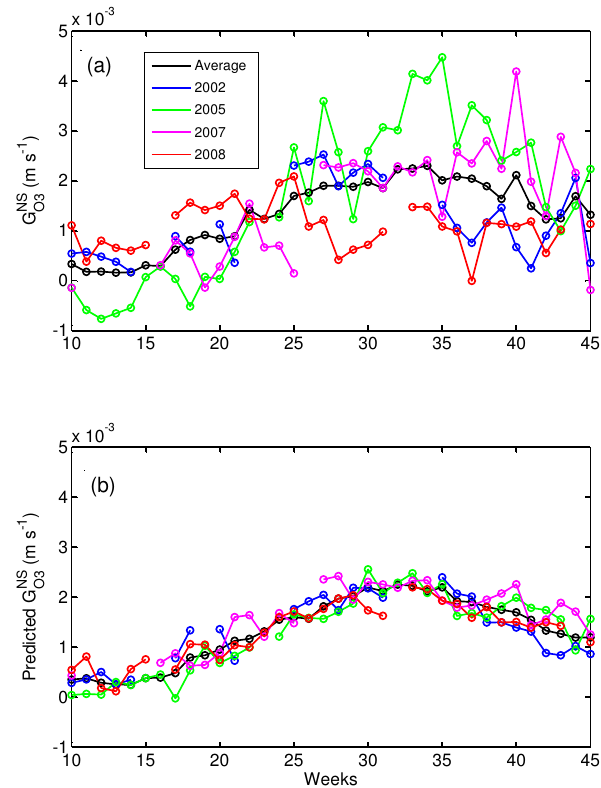
Fig. 9. Weekly average non-stomatal O 3 conductance for day-time conditions (Solar elevation angle>10 ◦ ) as observed (a) and pre- dicted by using the partial least squares technique (b)